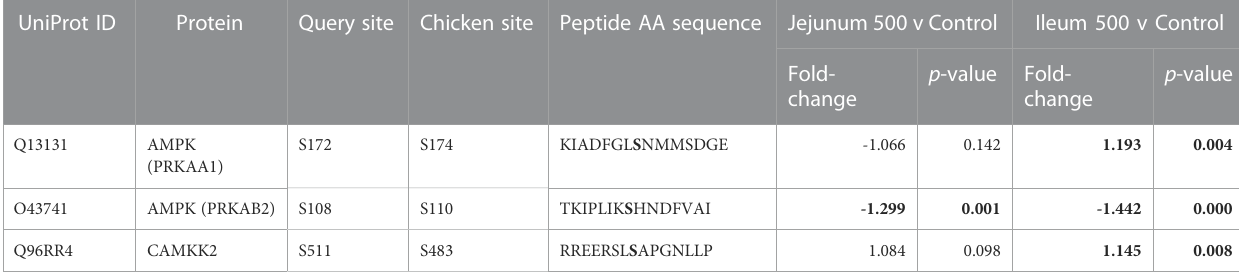
TABLE 7 AMPK and related proteins ’ phosphorylation events. Here, the kinome peptide array results are shown. Jejunum 500 and ileum 500 were compared to their respective control tissues. Phosphorylation events represented in this table show signi fi cant ( p -value < 0.05) for sites as described above. Signi fi cant values are highlighted in bold.